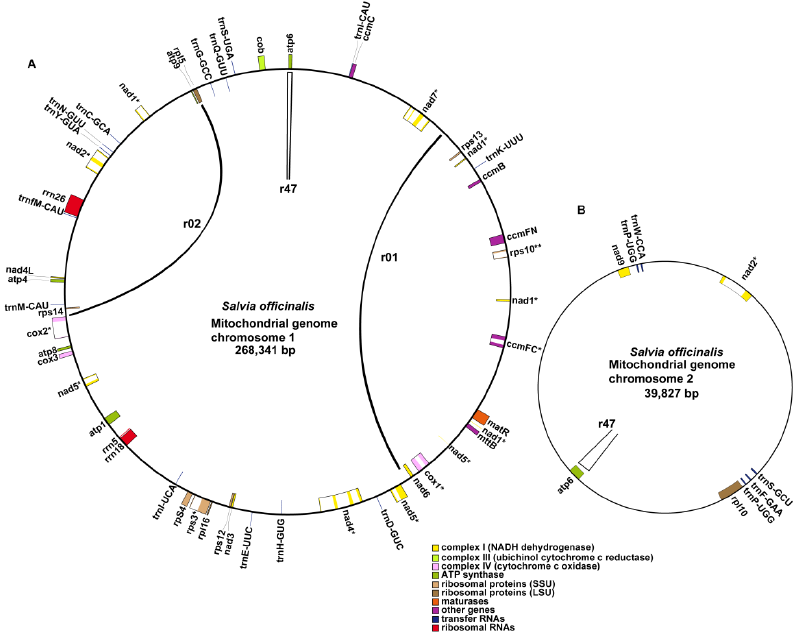
Figure 4. Schematic of the circular MC1 ( A ) and MC2 ( B ) of S. officinalis . The graph was drawn using PMGView (http://www.1kmpg.cn/pmgview (accessed on 28 October 2022)). Genes shown on the inside were on the negative strand, and those on the outside were on the positive strand. Genes with introns were highlighted using “*”. The colors indicate different functional categories . The locations of the three repetitive sequences (r01, r02, and r47) that could mediate homologous recombination in the S. officinalis mitogenome are highlighted inside the circles. The two repeat units of r01 and r02 are on chromosome 1 and are connected with arcs. In contrast, the two repeat units of r47 are distributed on chromosome 1 and 2.